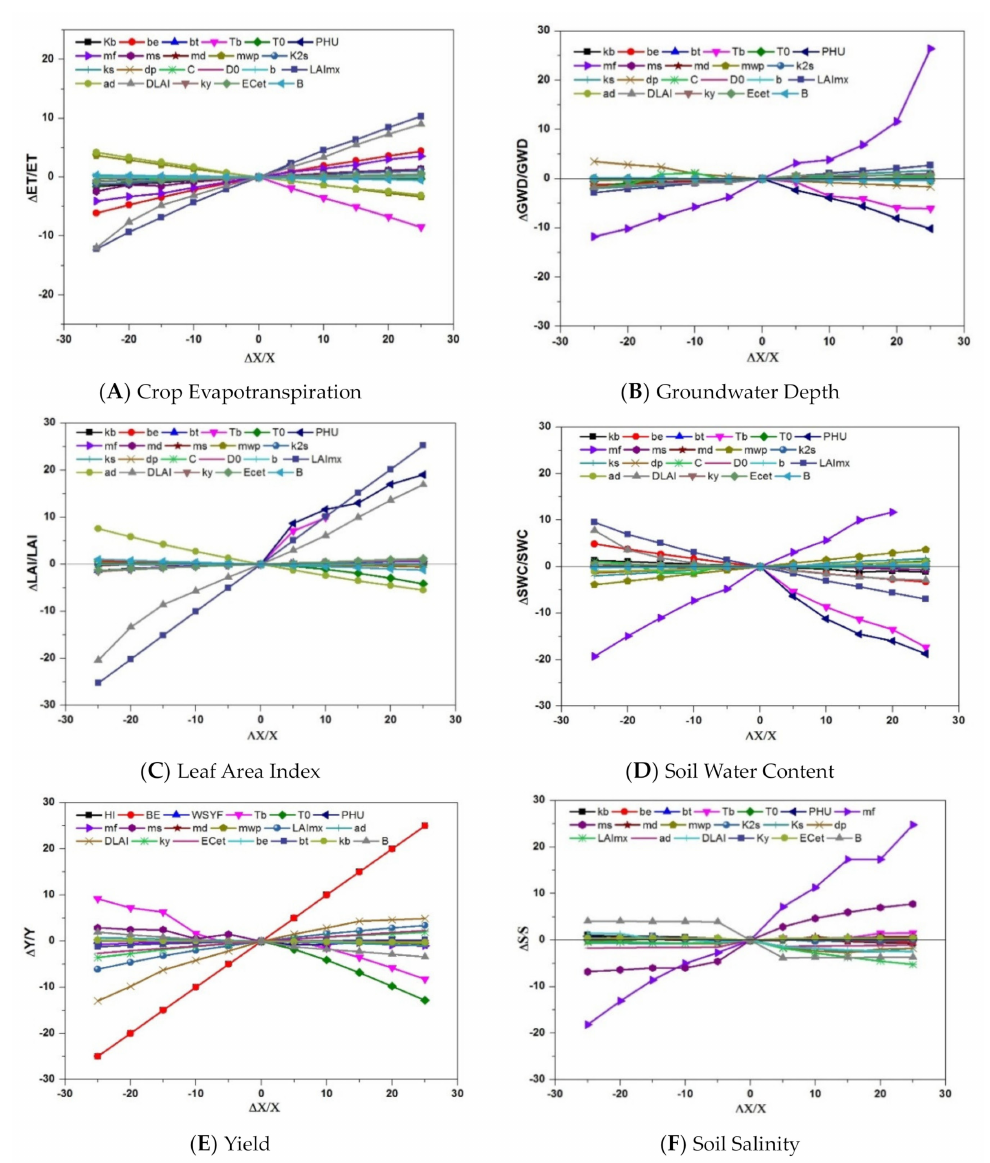
Figure A4. Parameters sensitivity analysis for ET, groundwater depth, LAI, soil water and salt content of 90 cm. Note: ( A ) is the sensitive analysis for ET, ( B ) is the sensitive analysis for groundwater depth, ( C ) is the sensitive analysis for LAI, ( D ) is the sensitive analysis for soil water content; ( E ) is the sensitive analysis for maize yield, ( F ) is the sensitive analysis for soil salt